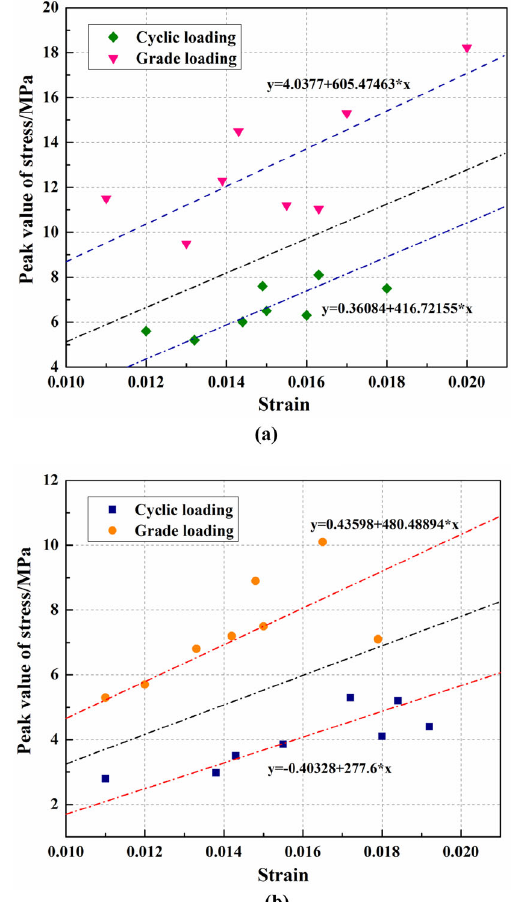
Fig. 9 The peak value of stress under different loading path. a